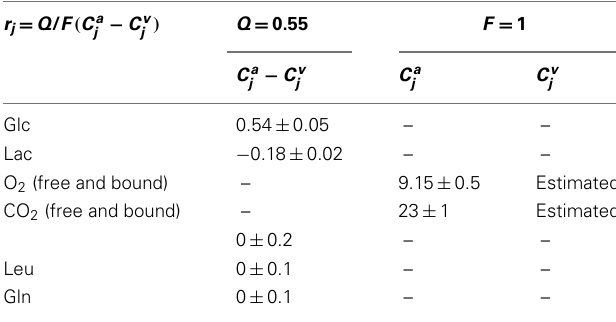
Table 3 | Input values defining the non-vanishing components of the right hand side r in equation